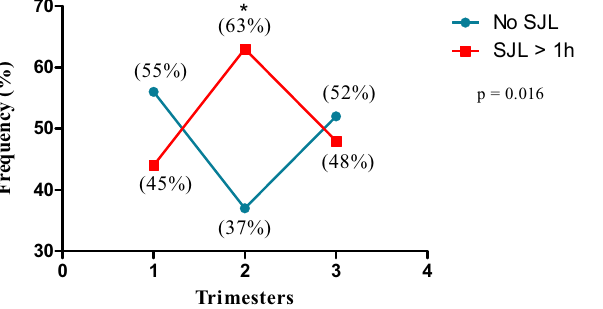
Figure 5. Frequency of social jetlag (SJL) by time category in pregnant participants over the three gestational trimesters in the longitudinal phase. The number of participants in each category is shown in parentheses (n = 100; n = 100 first trimester; 100 s trimester; and 100 third trimester). Note : p values were calculated using the Pearson’s chi-square test ( p < 0.05) and are comparative between the trimester of the longitudinal phase.